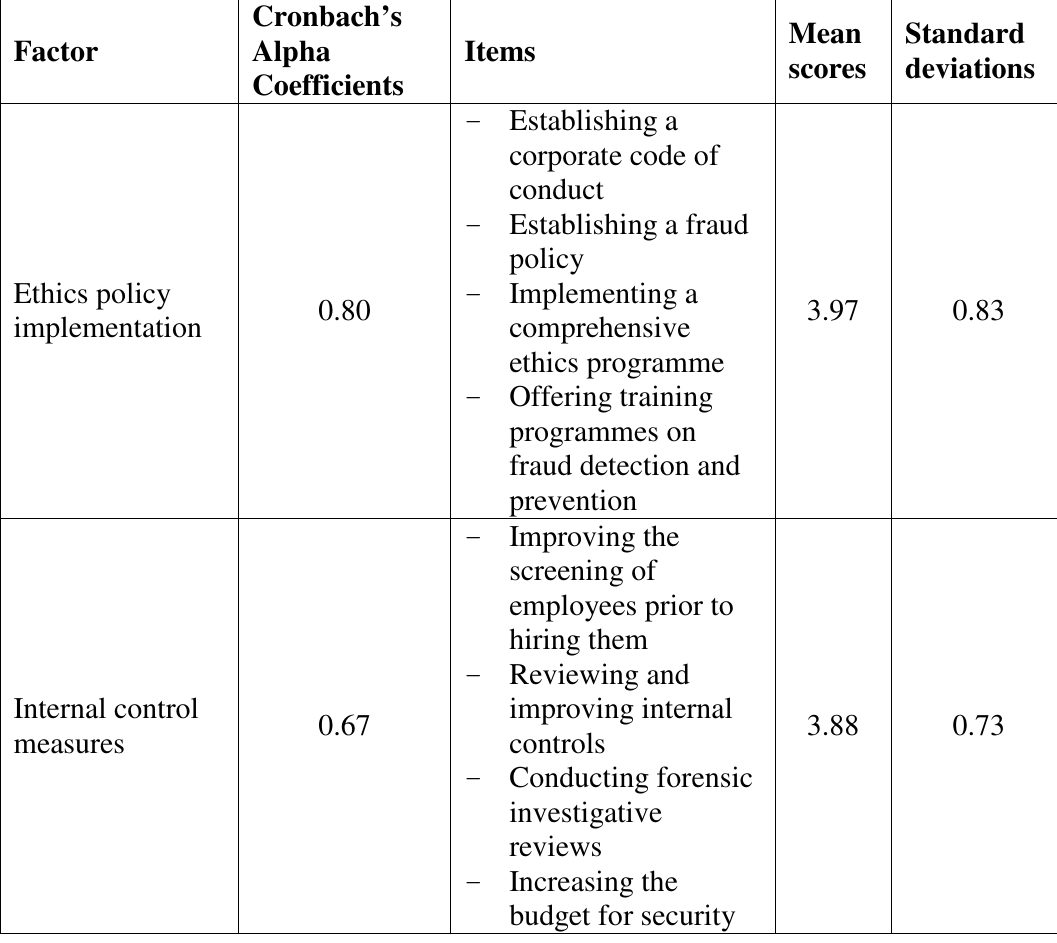
Table 5: Ethics policy implementation and internal control measures